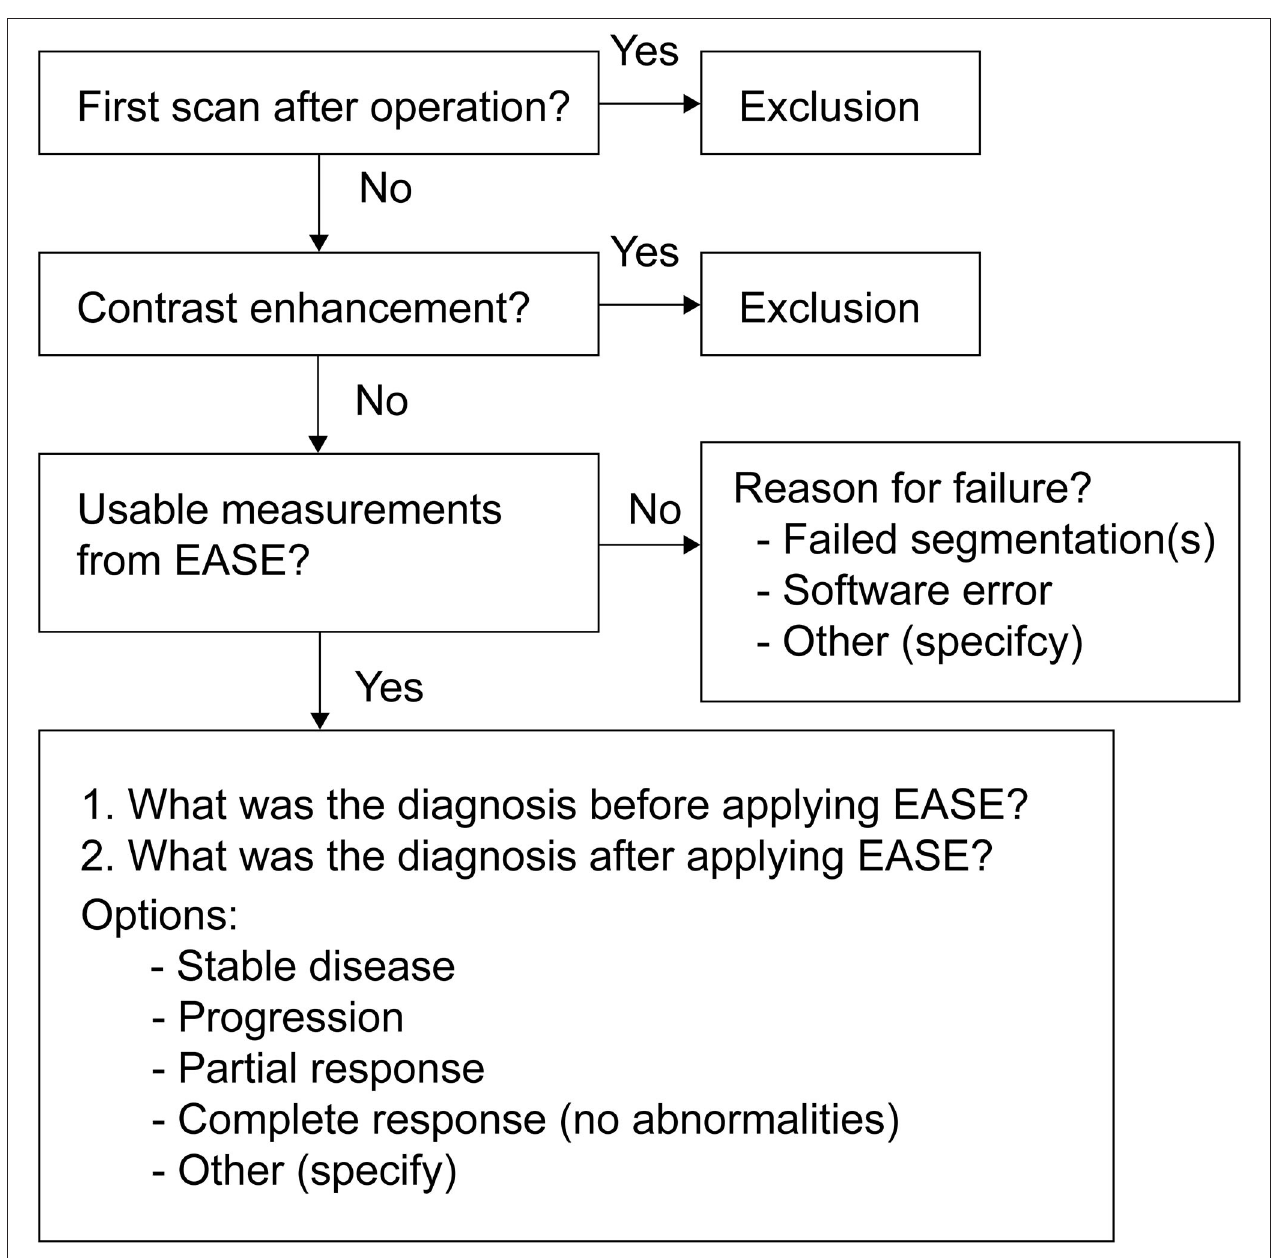
FIGURE 5 | Flowchart of the survey on the usage of EASE in clinical practice.